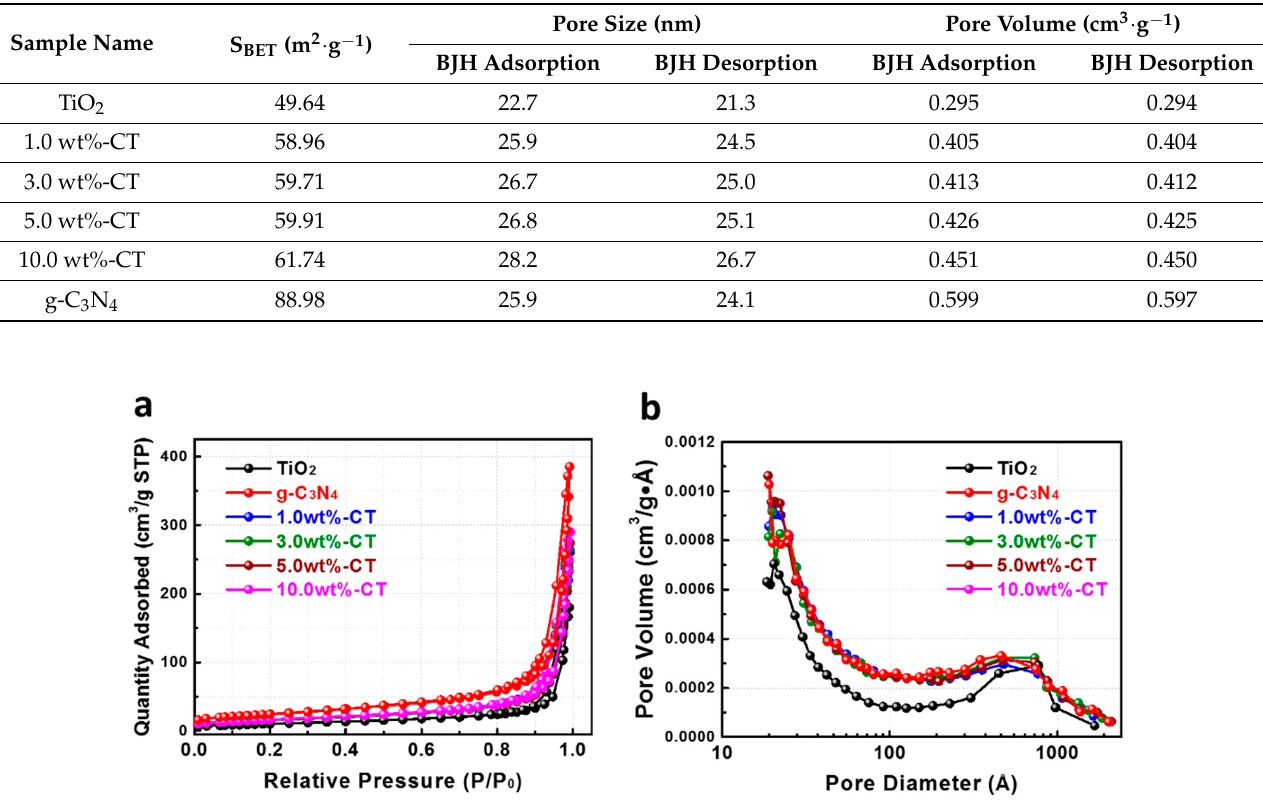
Figure 4. ( a ) Nitrogen adsorption − desorption BET isotherm curves and ( b ) related pore distribution curves of various g-C 3 N 4 /TiO 2 catalysts.